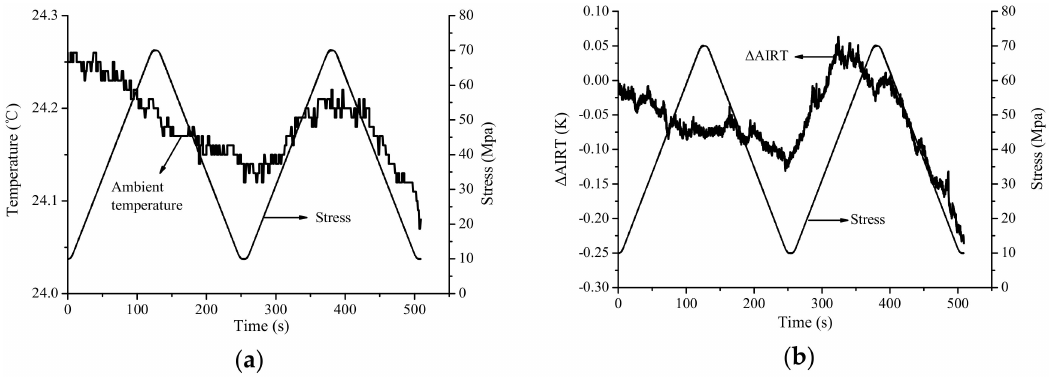
Figure 6. The measured results of sample HG-4 in the cyclic loading process: ( a ) The ambient temperature change; ( b ) ∆ AIRT